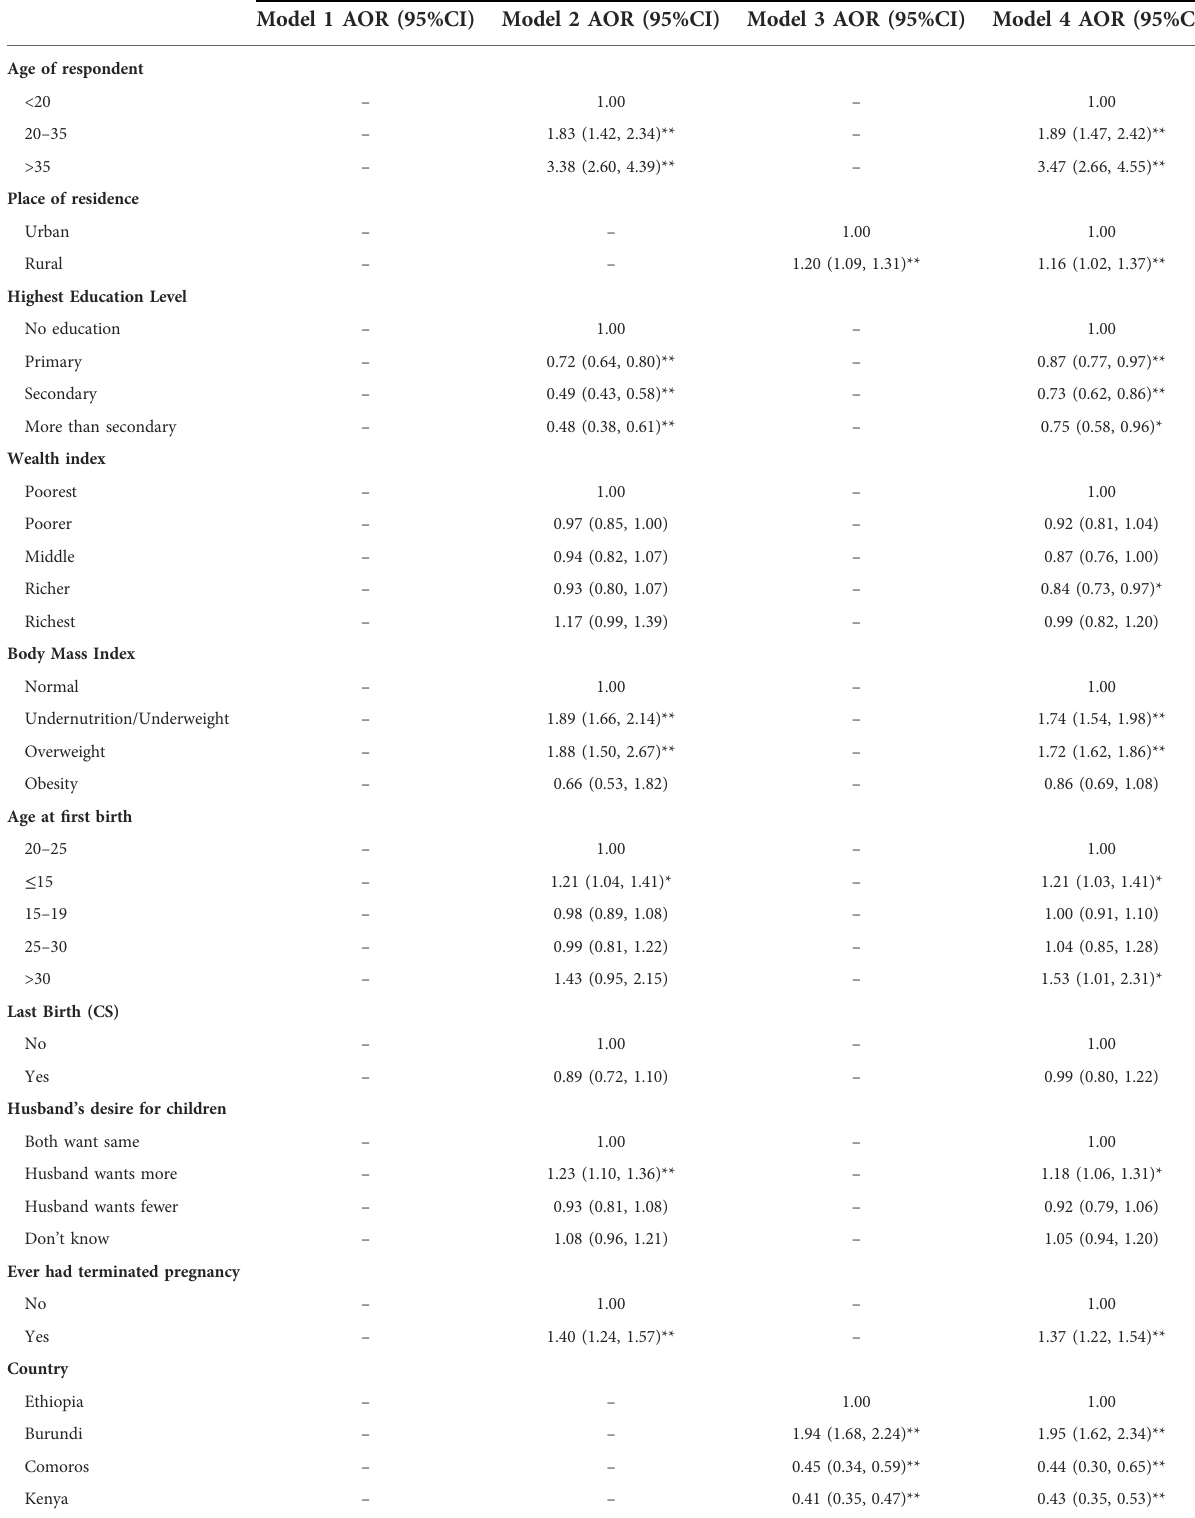
TABLE 4 Multi-variable multilevel logistic regression analysis of factors associated with secondary infertility in East